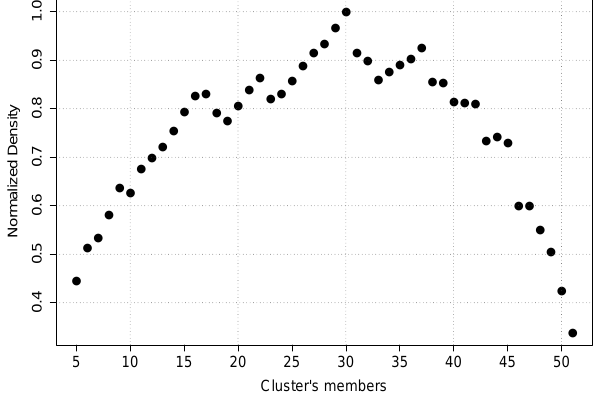
Fig. 2. Common pattern of normalized cluster density as a function of the number of events that make up a cluster. Example for an Adriatic Sea cluster: the pruned cluster is made up of 30 members which maximize the cluster